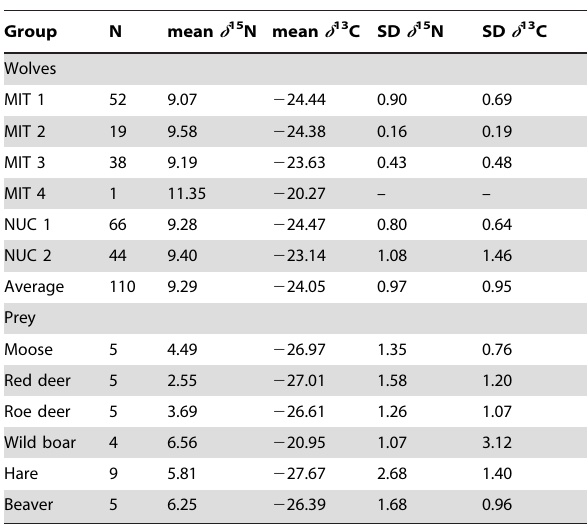
Table 2. Mean values and standard deviation of d 15 N and d15N values ( % ) for Eastern European wolves and their